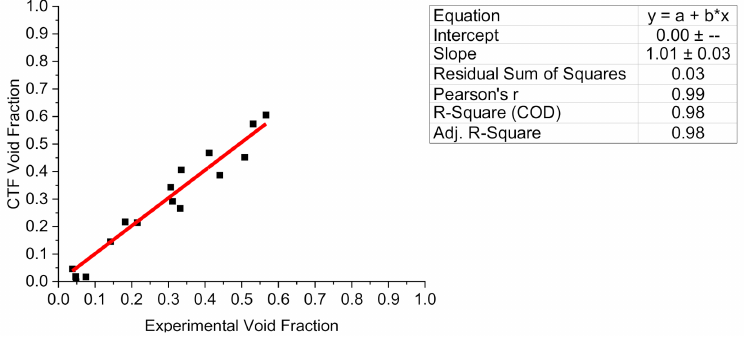
Figure 4. CTF vs. experimental void